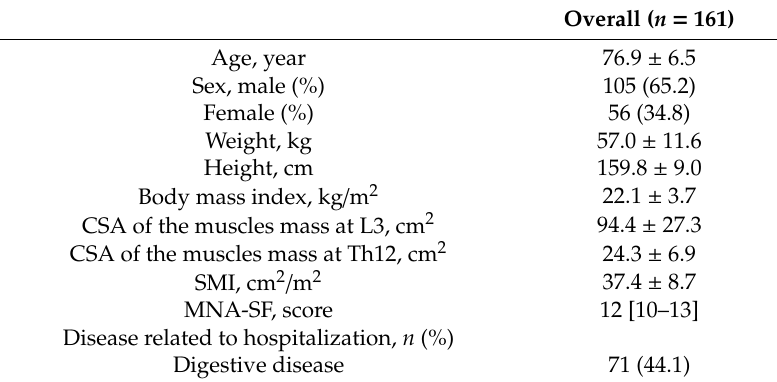
Table 1. Characteristics of patients in the development